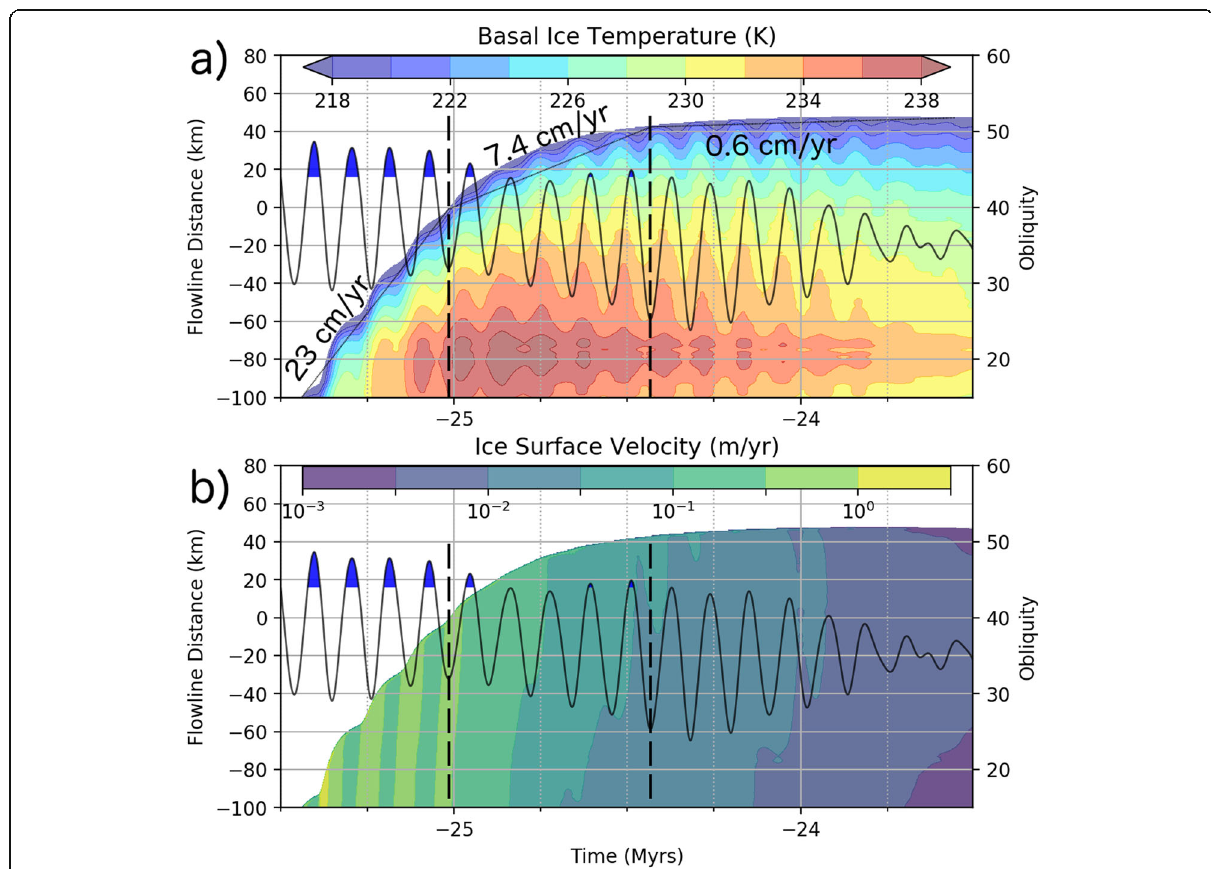
Fig. 12 Increased time resolution model output showing details of the change in ice flow velocity in response to ice accumulation and obliquity- driven temperature change. Highest ice flow velocities follow episodes of ice accumulation. a Basal ice temperature increases with ice thickness (due to thermal conduction of the geothermal flux), while variations over a shorter timescale result from top-down conduction of obliquity variations. b Surface ice velocity response to episodes of accumulation (blue obliquity peaks) and obliquity-driven temperature changes. Dashed line indicate direction of velocity wave propagation (toeward after accumulation events, e.g., near − 25 Myr, and possibly headward in response to obliquity-driven temperature change, e.g., at − 24.4